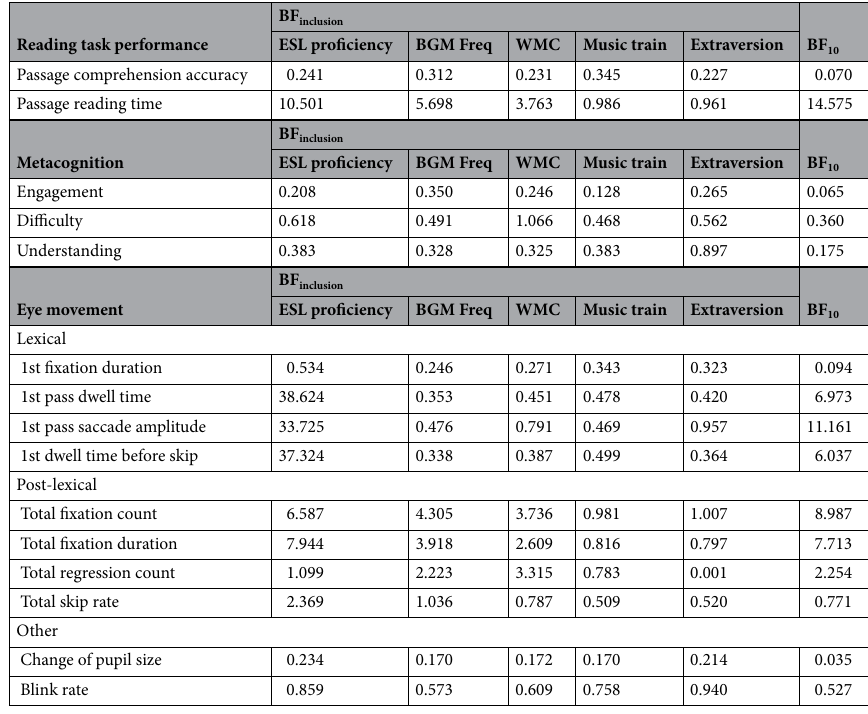
Table 8. Bayesian linear regression models of BGM group (Experimental). Please refer to Note below Table 6 for abbreviation definition.